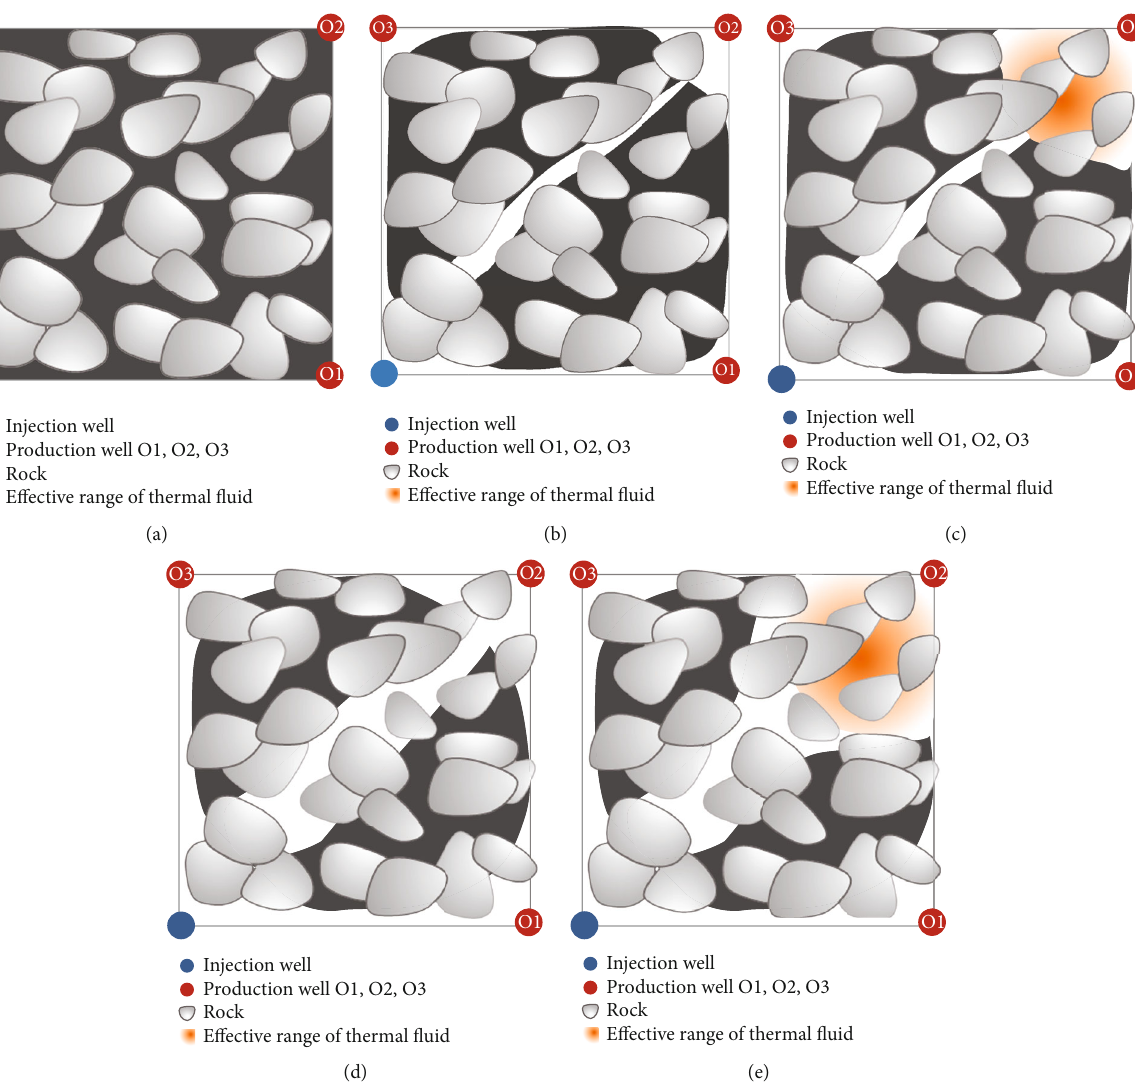
Figure 9: Mechanism diagram. (a) Crude oil distribution in the original reservoir. (b) Crude oil distribution after water fl ooding. (c) Crude oil distribution after thermal recovery. (d) Crude oil distribution after conformance control. (e) Crude oil distribution after combined operation ( “ conformance control fl ooding and thermal recovery ”